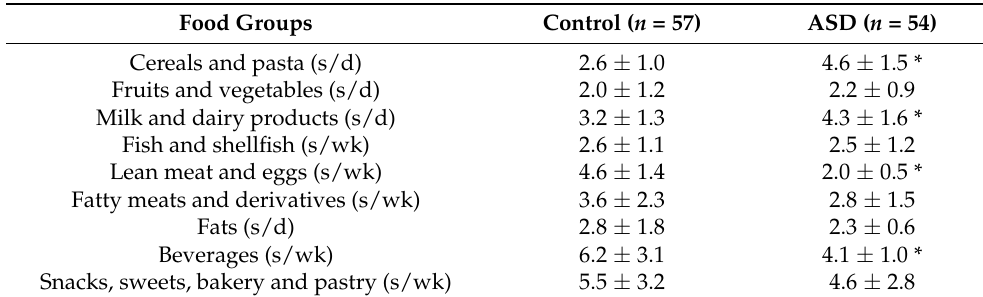
Table 2. Food group consumption according to food frequency questionnaires in Spanish preschool children with autism spectrum disorders